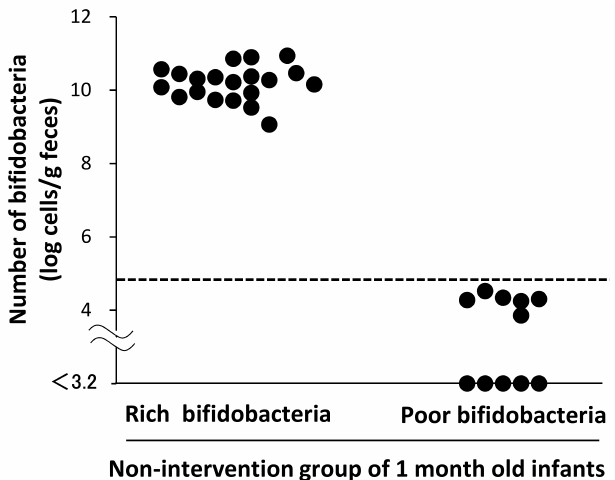
Figure 2. Fecal bifidobacterial counts in the non-intervention control group at 1 month of age. The horizontal dotted line indicates the representative value of the lower limit of the 95% confidence interval of the bifidobacterial counts in Japanese term infants